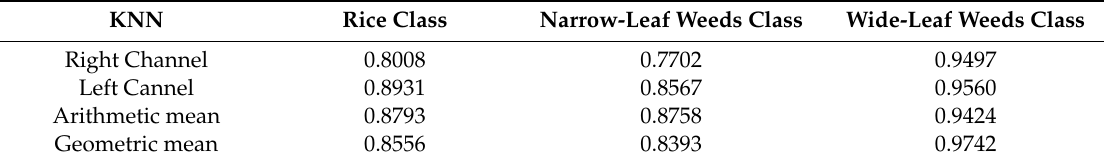
Table 9. Mean area under the ROC curves (AUC) for the KNN classifier for rice, narrow-leaf weed, and wide-leaf weed classes: right channel, left channel, arithmetic mean, and geometric mean.